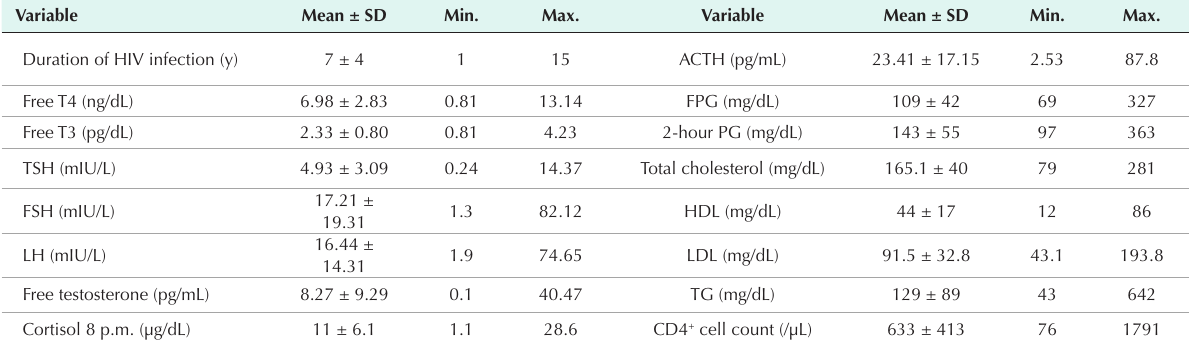
Table 2. Laboratory Findings in HIV-positive Population Variable Mean ± SD Min. Max. Variable Mean ± SD Min.